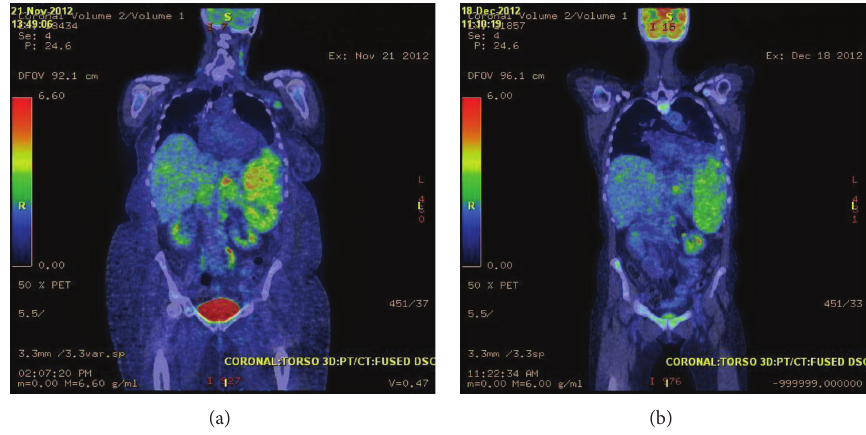
Figure 2: (a) PET/CT scan prior to chemotherapy. (b) PET/CT scan after 2 cycles of chemotherapy.